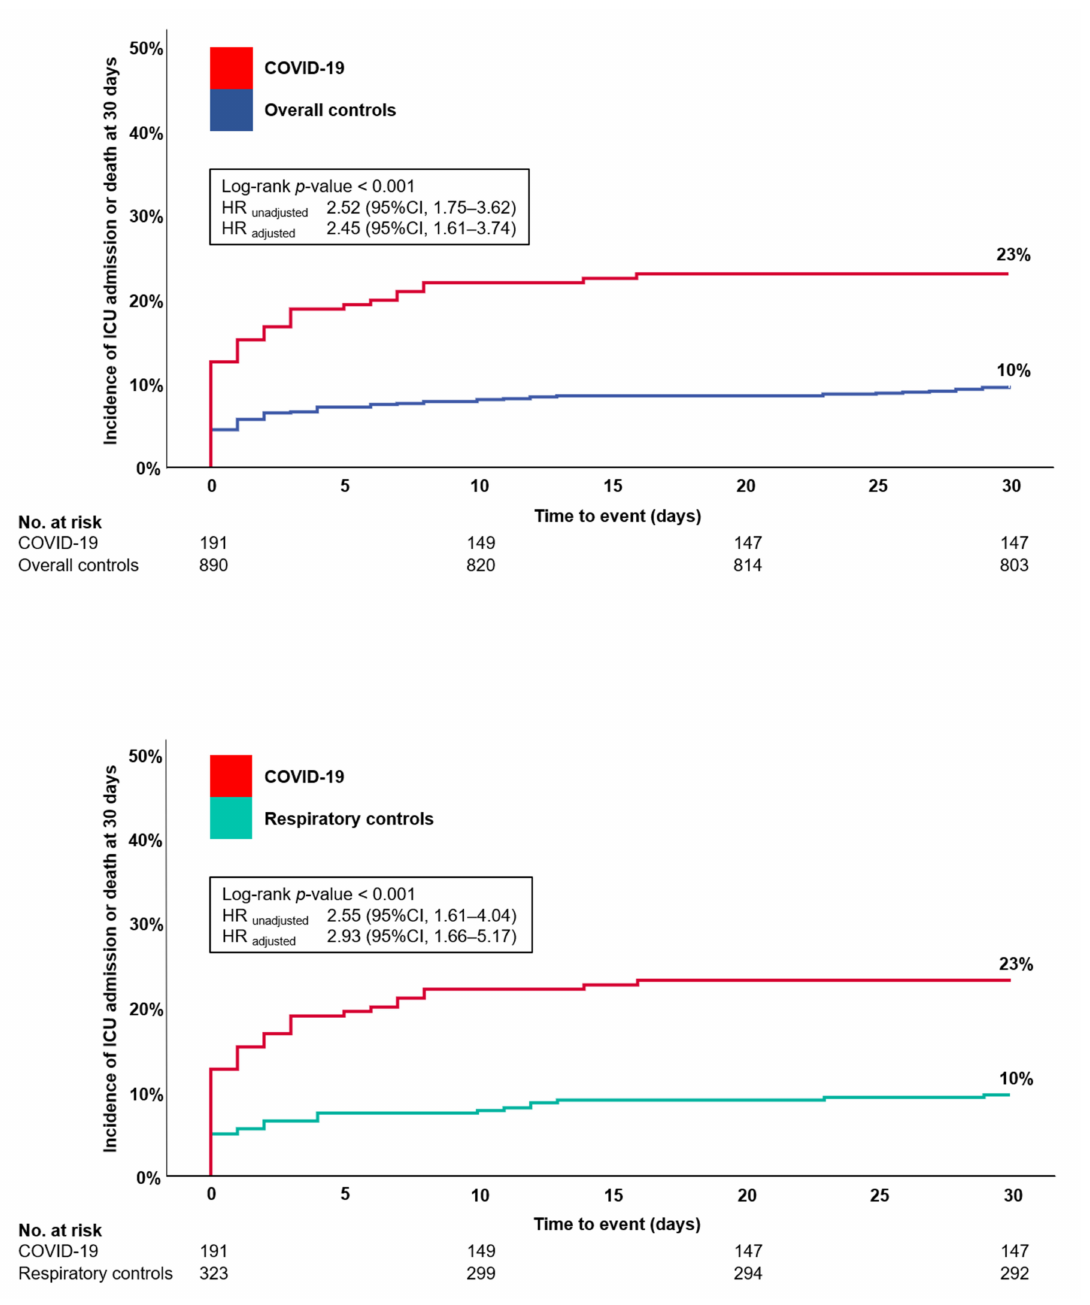
Figure 1. Event curve for ICU admission and death at 30 days in COVID-19 and controls. First panel shows incidence of ICU admission and death at 30 days for COVID-19 vs. overall controls. Second panel shows incidence of ICU admission and death at 30 days for COVID-19 vs. respiratory controls, adjustments were made for cardiac disease, pneumopathy, overweight, diabetes, active smoking, CRP, and blood oxygen saturation; ICU = intensive care unit, COVID-19 = coronavirus disease 2019, HR = hazard ratio, CI = confidence interval, CRP = c-reactive